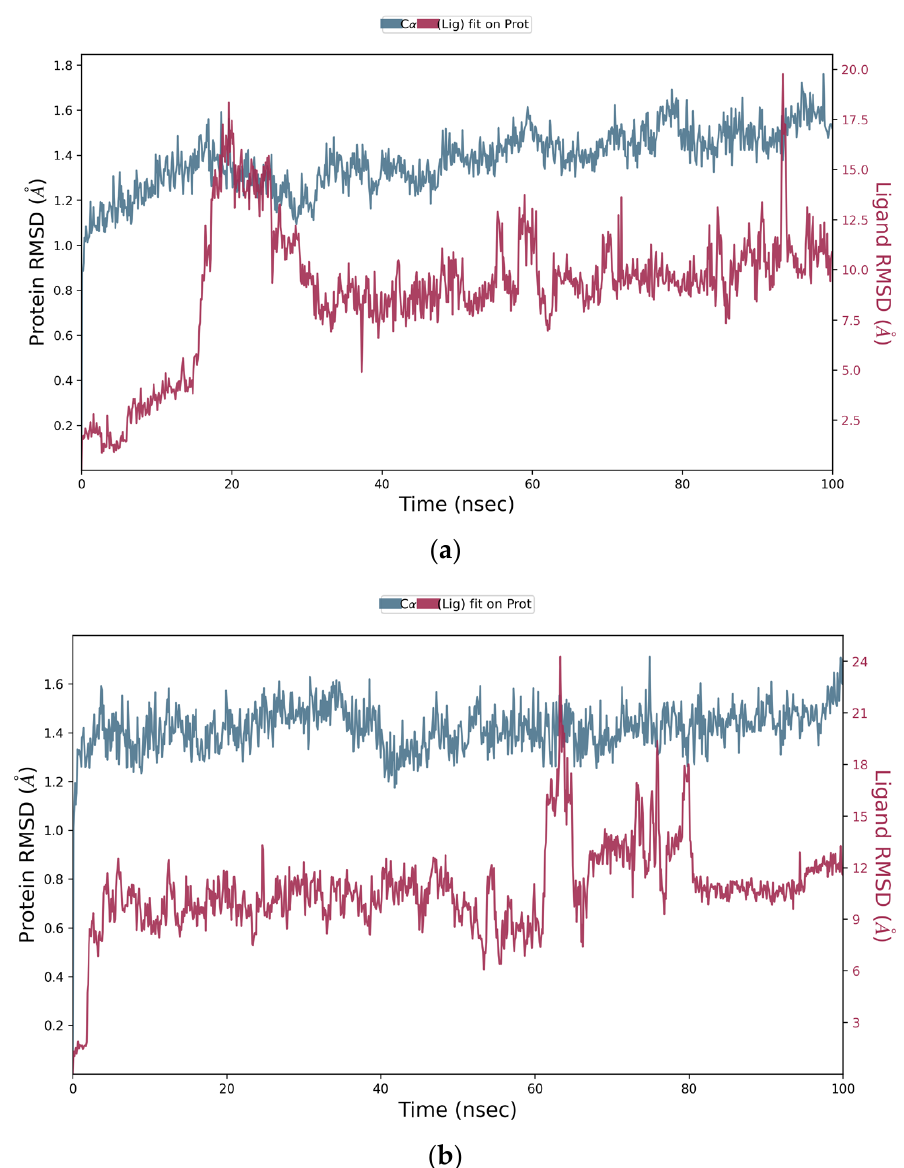
Figure 3. RMSD plot of Tradescantia pallida ’s compounds with human α -glucosidase protein 5NN5: ( a ) FTP1 and ( b ) FTP2;FTP1 is morin, FTP2 is catechin.